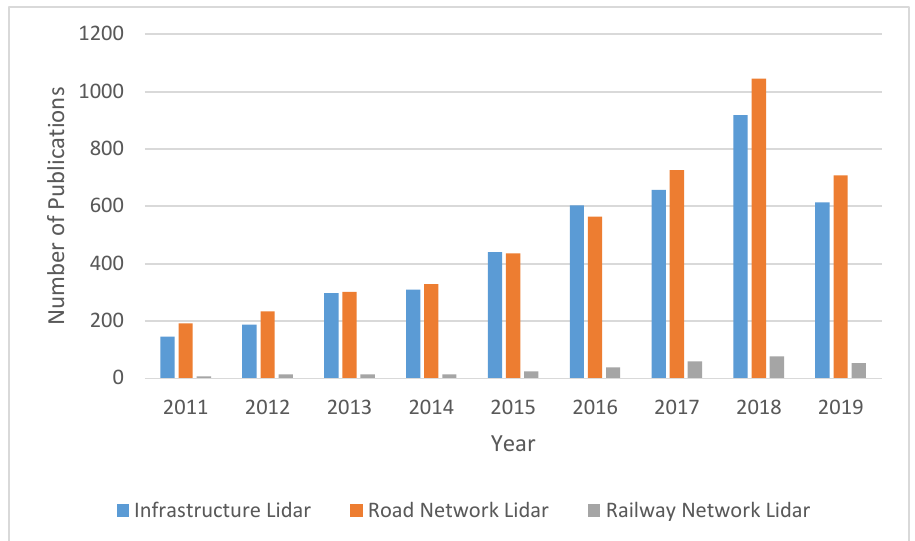
Figure 1. Number of publications per year related with LiDAR technology and infrastructure management applications. The legend shows the keywords used for the publication search. Only seven months of year 2019 are considered in the search [16].